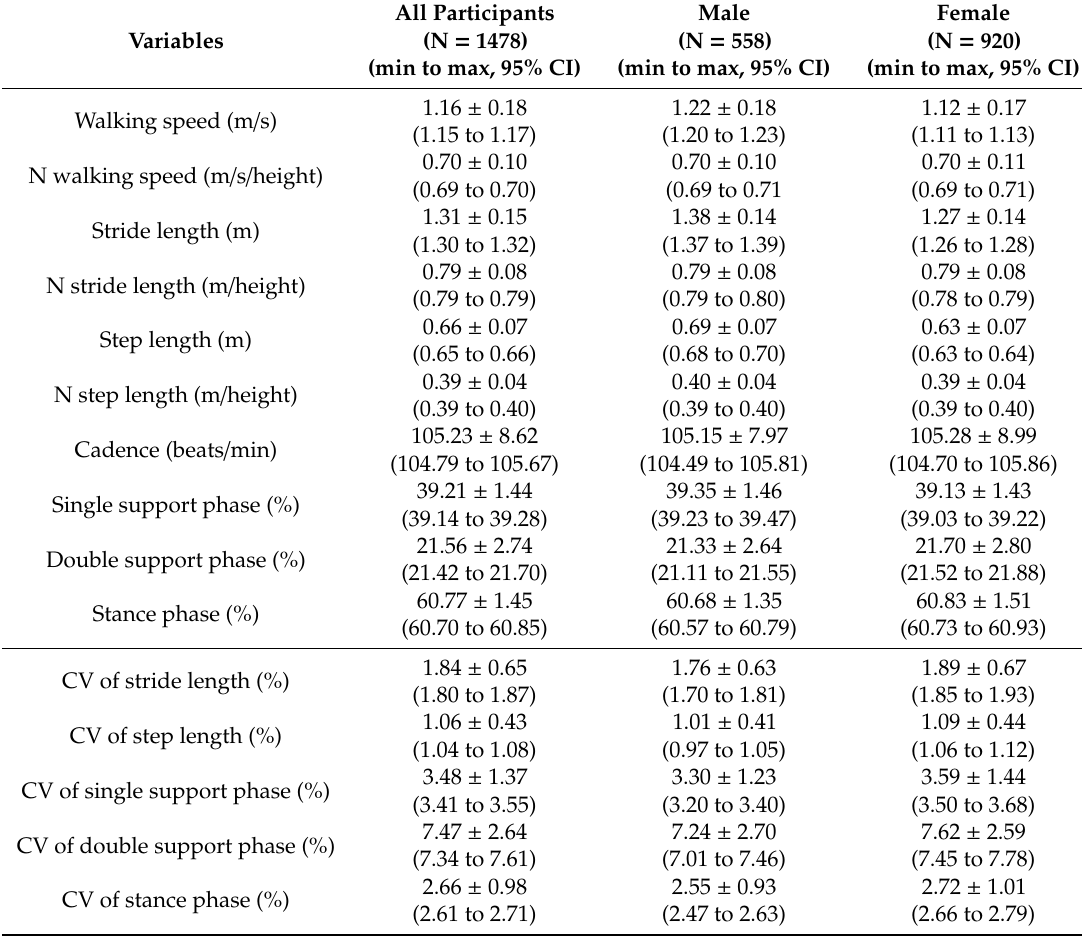
Table 3. Results of gait-related variables in healthy young adults: spatiotemporal parameters and gait variability (GV).